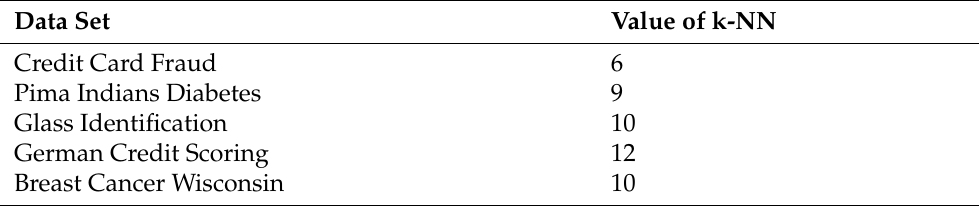
Table 4. Optimal parameter values for k-NN for each data